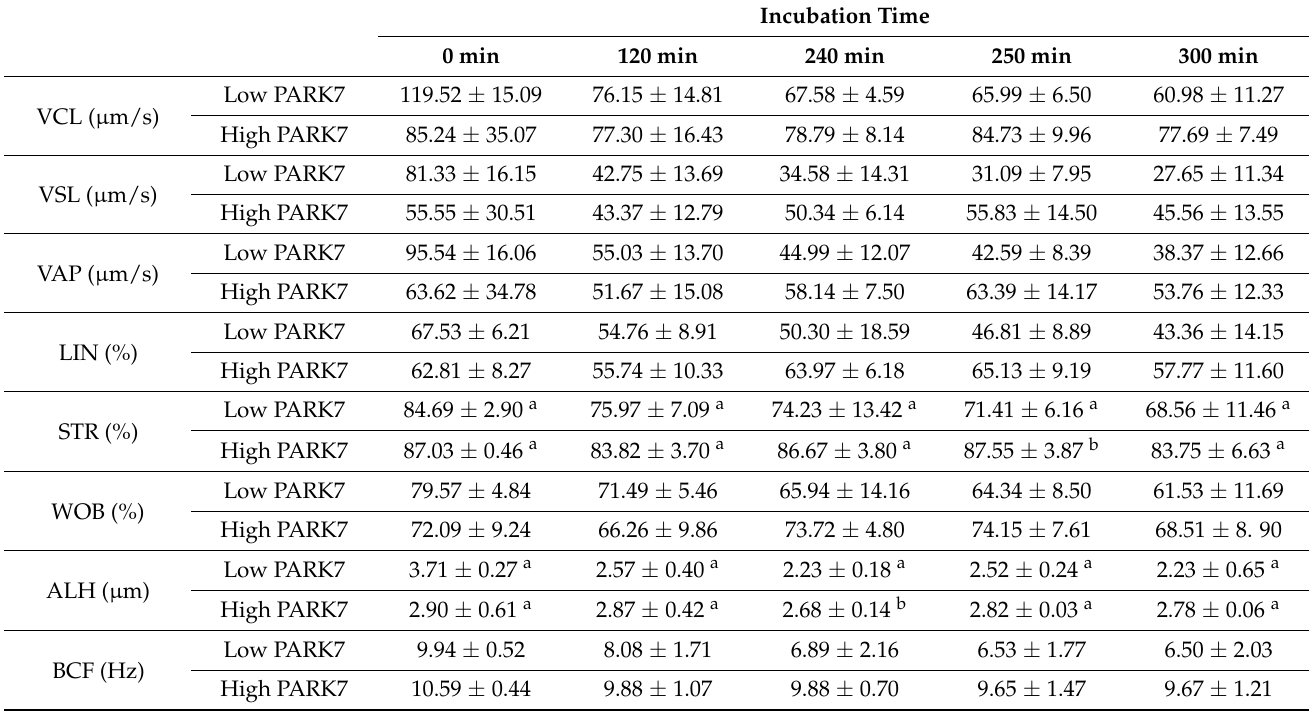
a,b indicate significant differences ( p < 0.05) between sperm samples containing high or low levels of